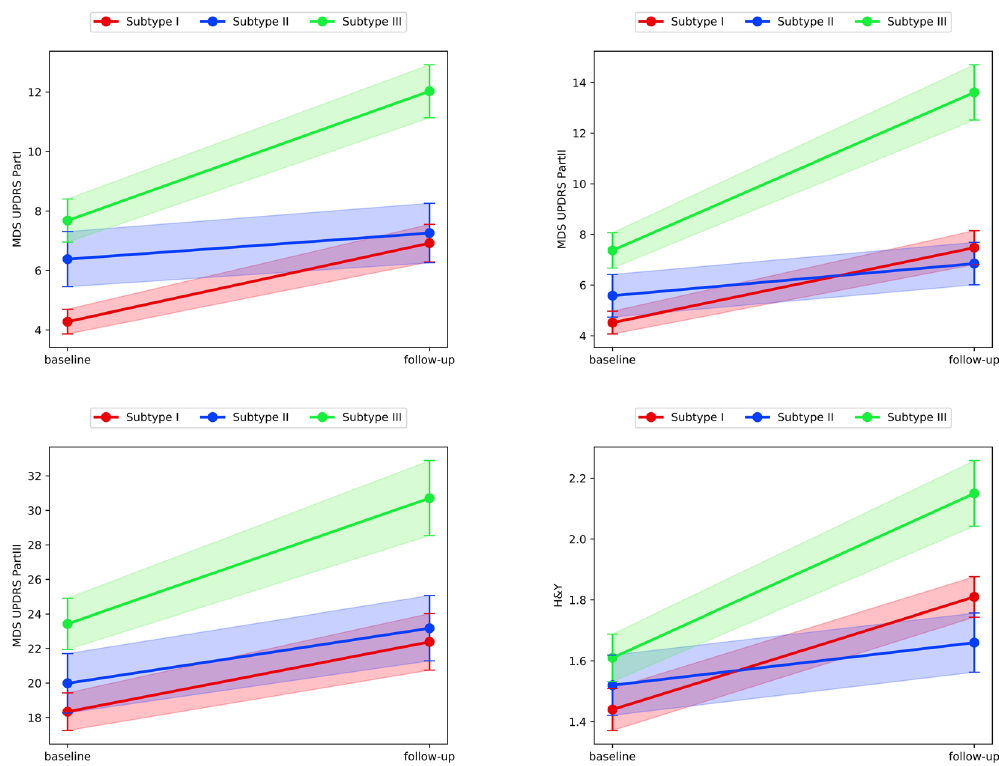
Figure 4. Comparisons of three Subtypes on disease progression of the variable MDS-UPDRS Part I-III, and H&Y. The time interval between baseline and follow-up is 6 years. The larger slope illustrates a more rapid progression on the corresponding variables. The filled regions indicate 95% Confidence Intervals as error bars for corresponding point estimates. Variables with the p-value < 0.05 are